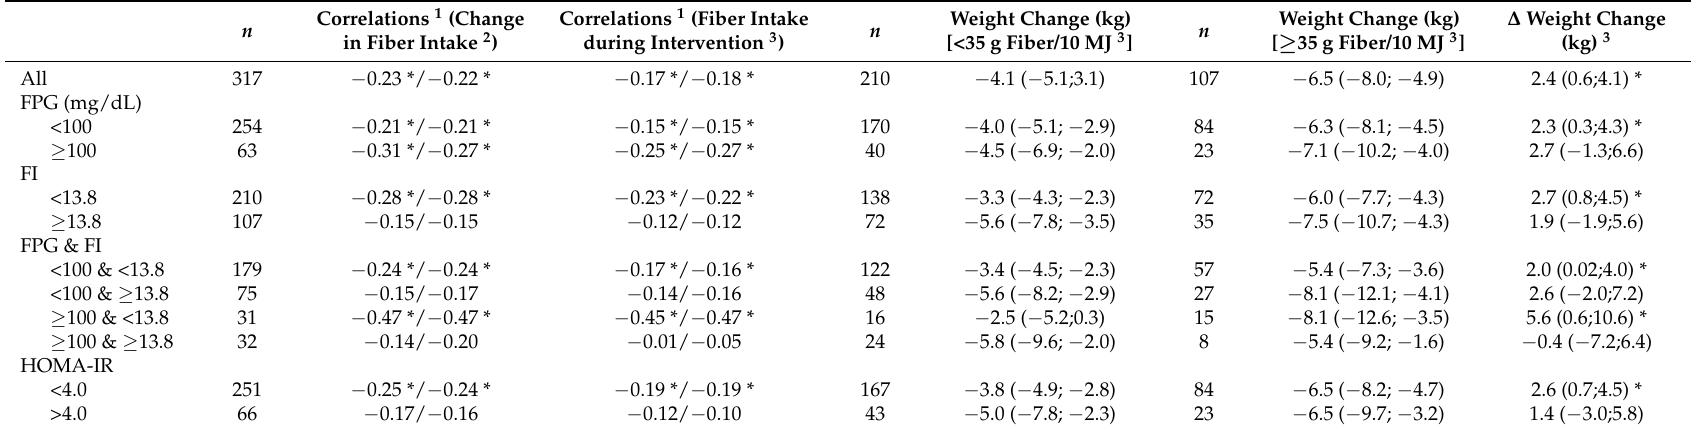
Table 4. Correlations between self-reported dietary fiber intake (g/10 MJ) and 24-month weight change (24-month − baseline) as well as weight change in groups of dietary fiber intake according to baseline glycemic and insulinemic